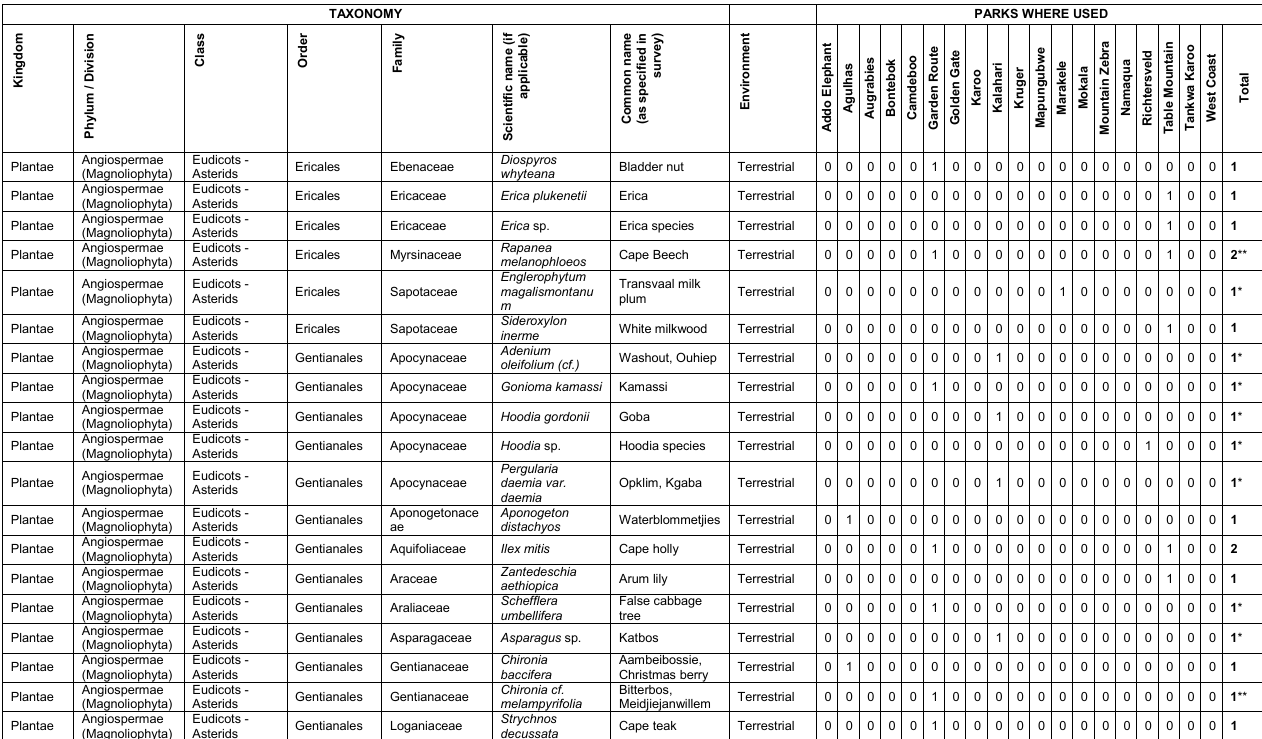
TAXONOMY PARKS WHERE USED